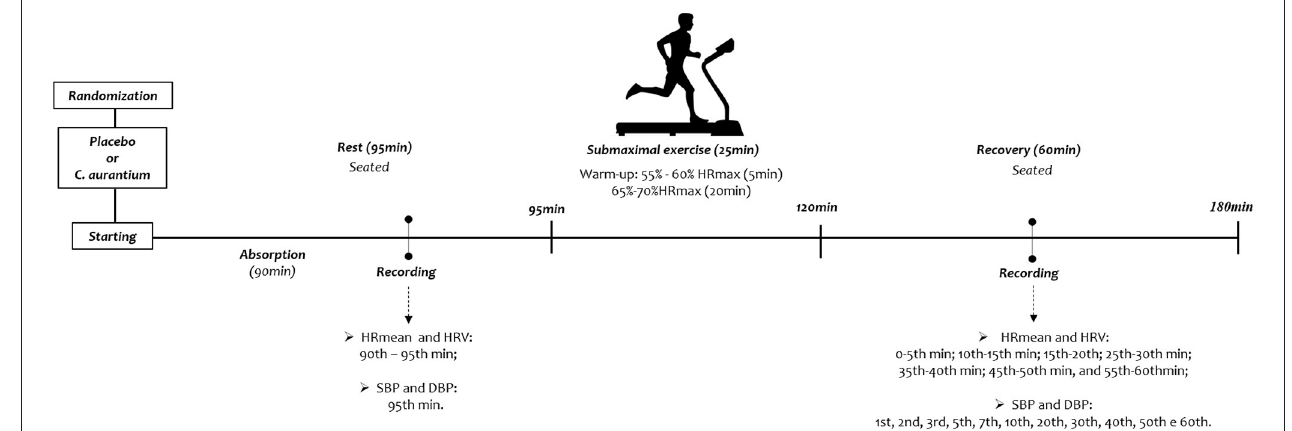
FIGURE 2 | Study design.